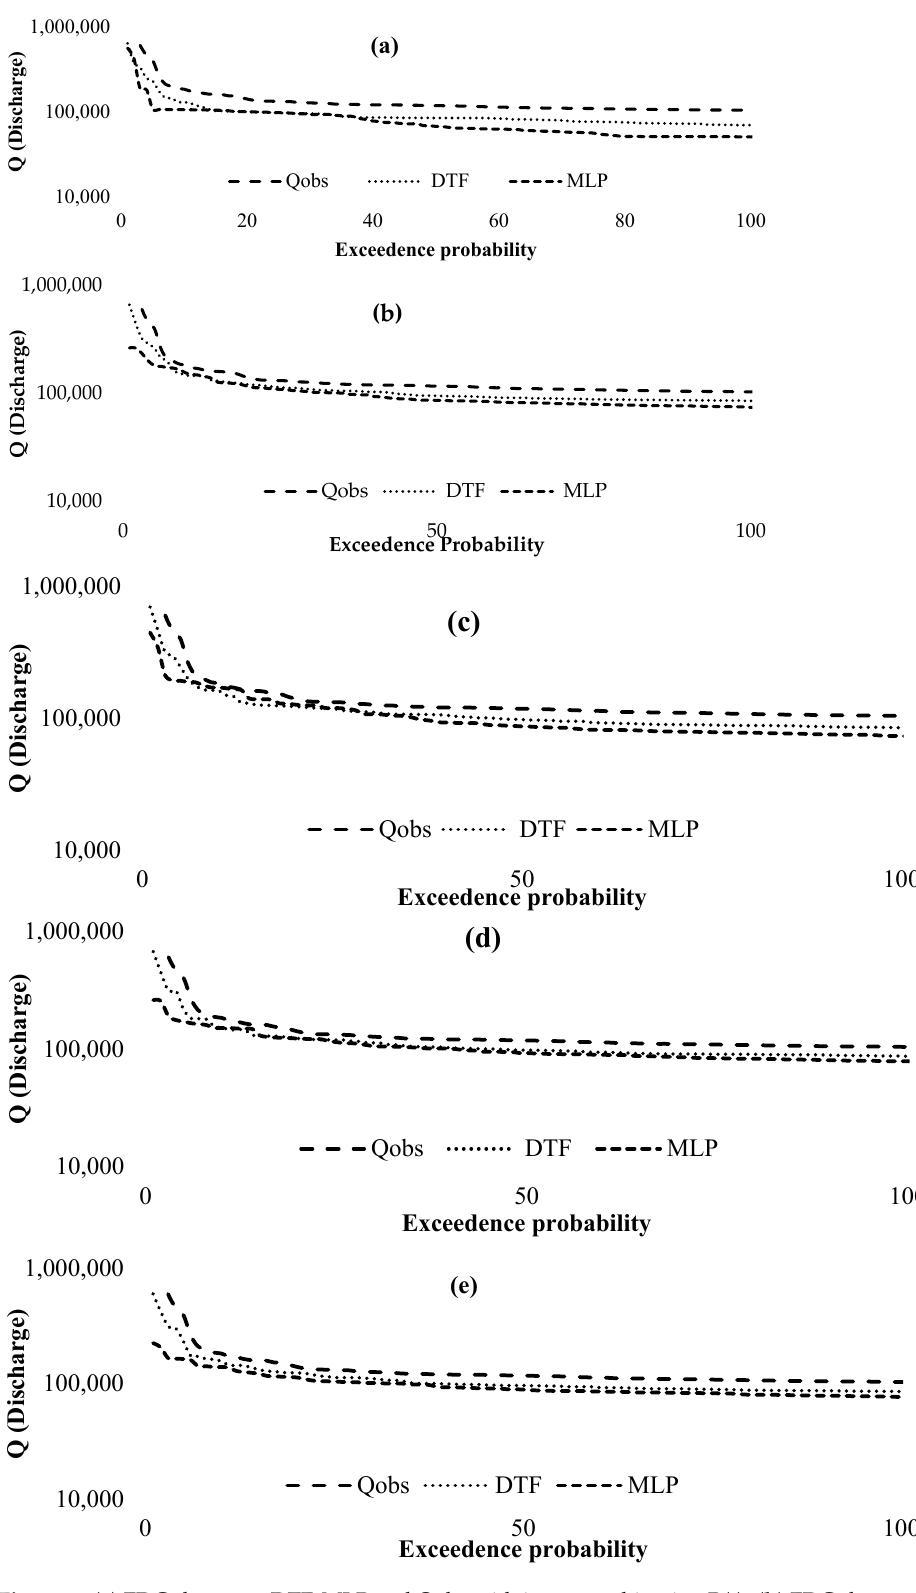
Figure 9. ( a ) FDCs between DTF, MLP and Qobs with input combination R(t). ( b ) FDCs between DTF, MLP and Qobs with input combination R(t ‐ 3). ( c ) FDCs between DTF, MLP and Qobs with input combination R(t ‐ 5). ( d ) FDCs between DTF, MLP and Qobs with input combination R(t ‐ 8). ( e ) FDCs between DTF, MLP and Qobs with input combination R(t ‐ 10).